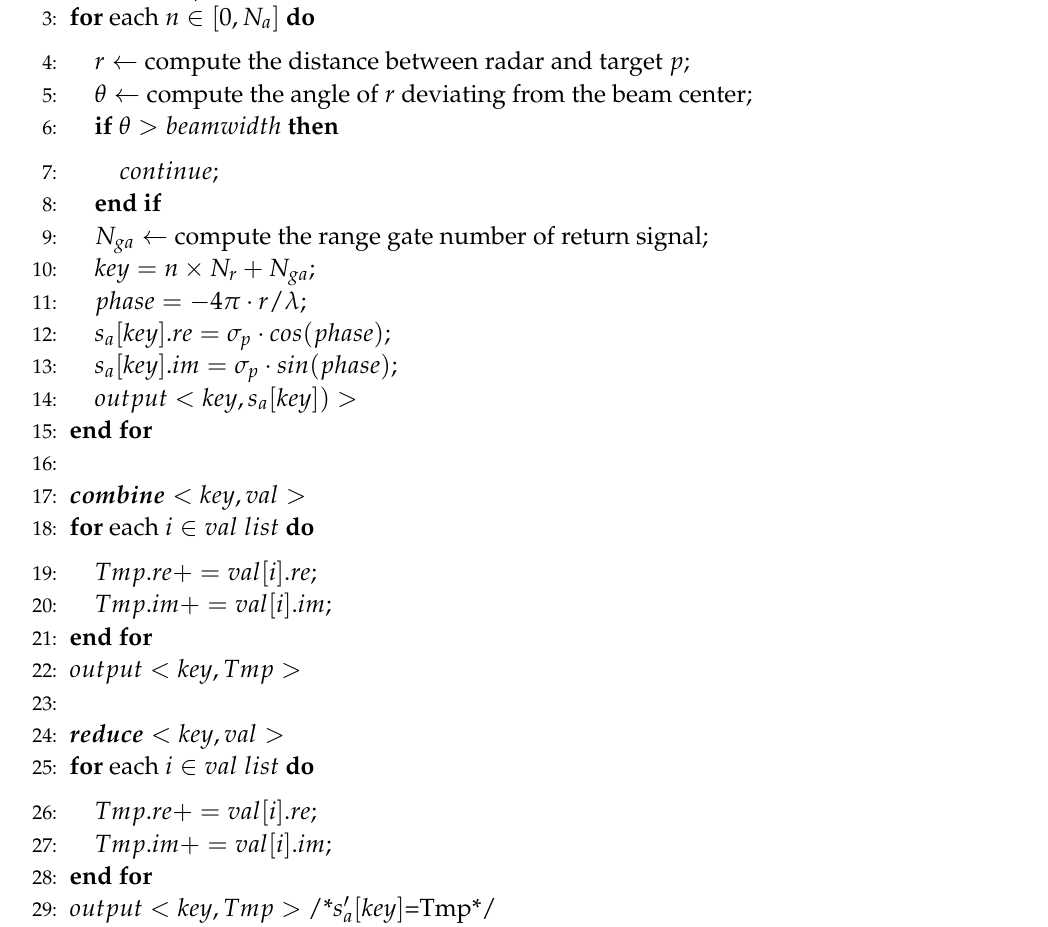
Algorithm 3 Cloud computing based raw data simulation: MapReduce